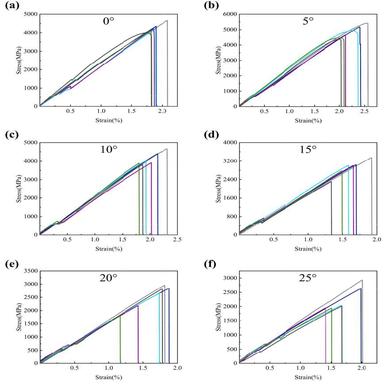
Stress–strain curves of carbon fiber tows under uniaxial tension with twist angles from 0◦ to 25◦.